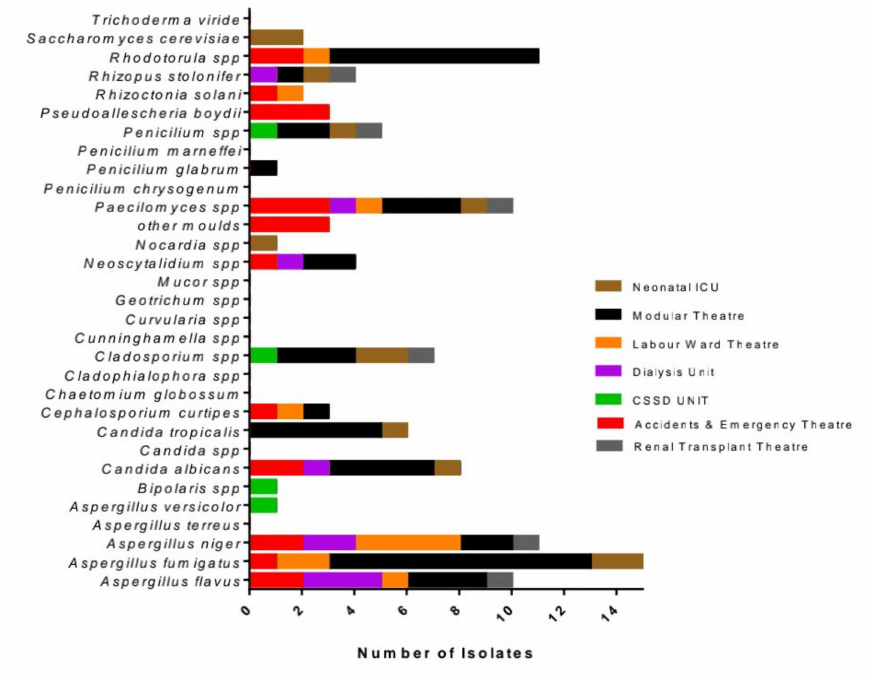
Figure 2. Distribution of isolates in water samples from high risk